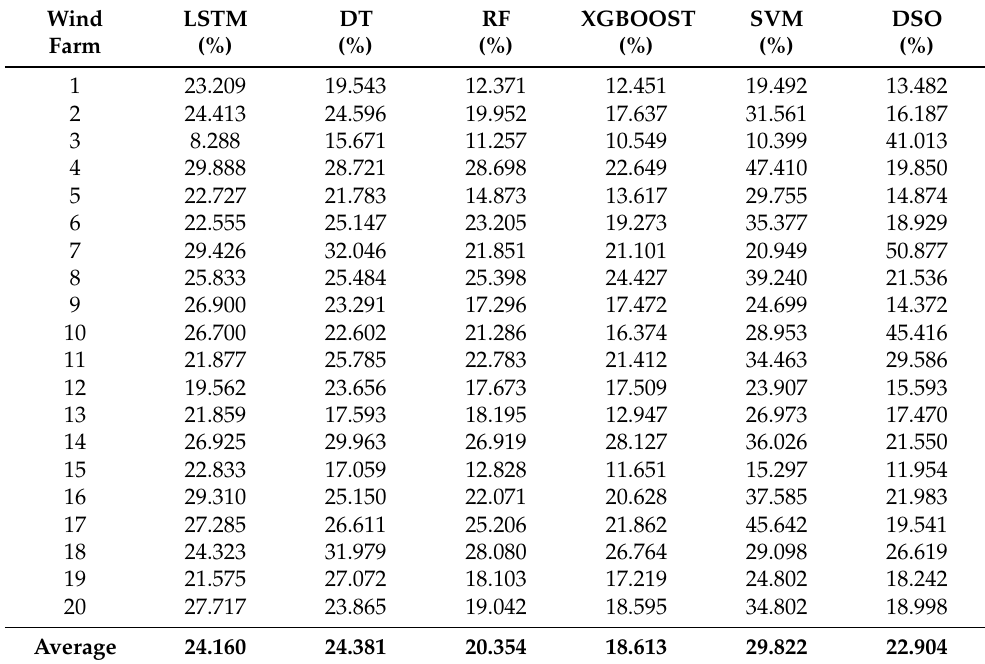
Table 3. RRMSE for LSTM, DT, RF, XGBOOST, and SVM: 6 months training, 1-month